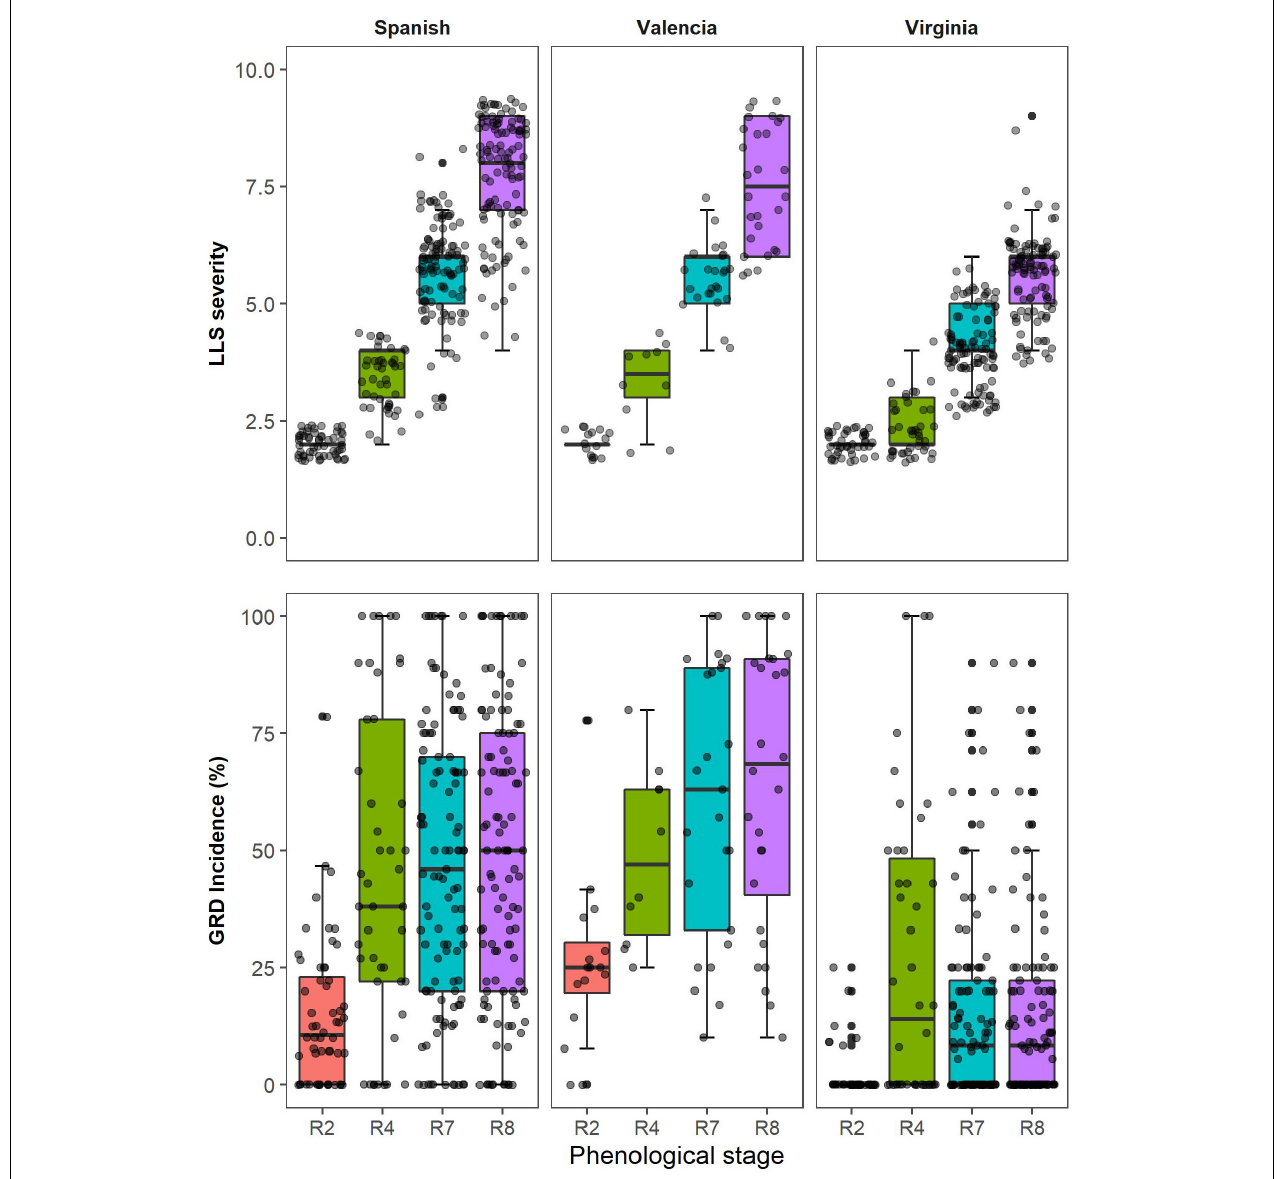
FIGURE 6 | Distribution of visual scores of Late leaf spot (LLS) severity and Groundnut rosette disease (GRD) incidence for genotypes belonging to three groundnut market types (Spanish, Valencia, and Virginia) at different phenological stages within the season.